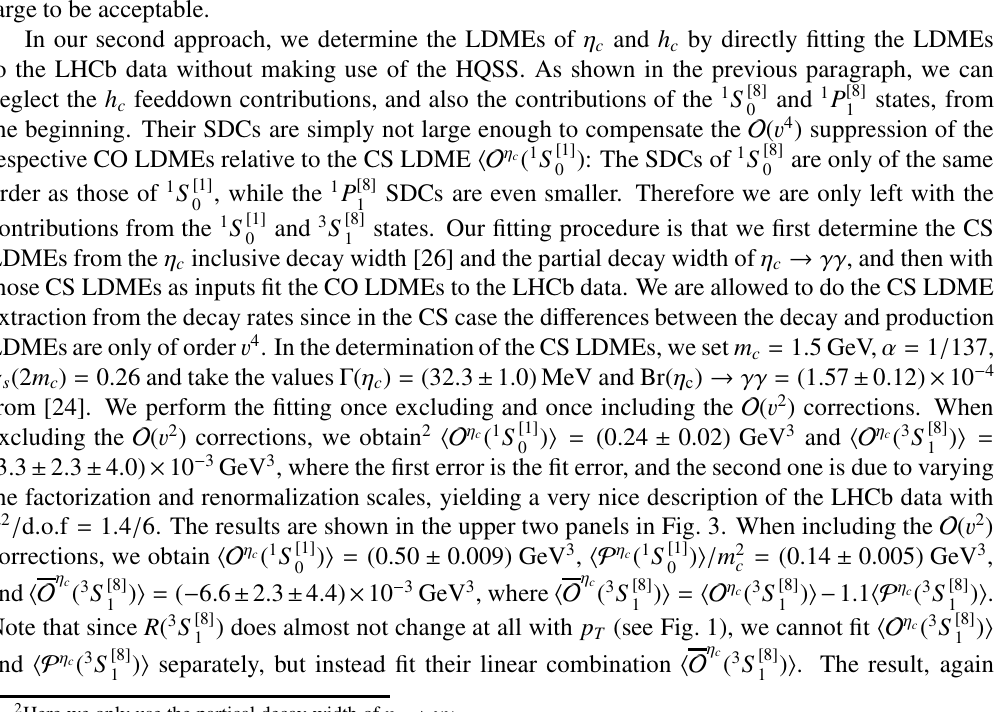
lower bounds of the respective error bands in Fig. 2, the χ 2 / d . o . f descends to 36 . 7 / 7, which is still